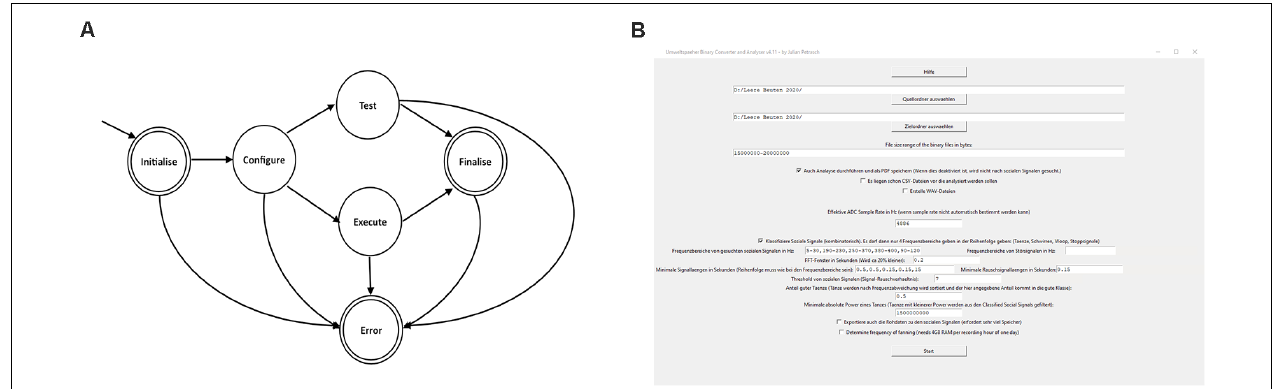
FIGURE 4 | State machine and graphic surface of the converter and analyzer. (A) Schematic diagram of the state machine (see text). (B) The converter and analyzer graphical user interface.